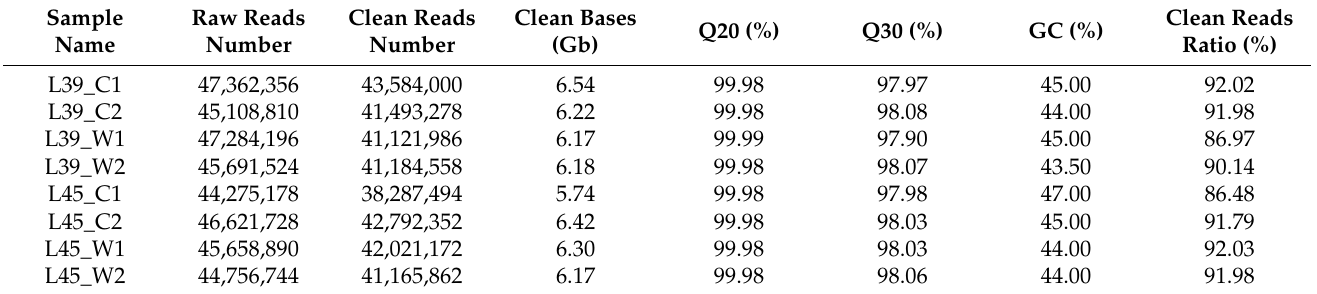
Table 1. Summary of transcriptome data after filtering.